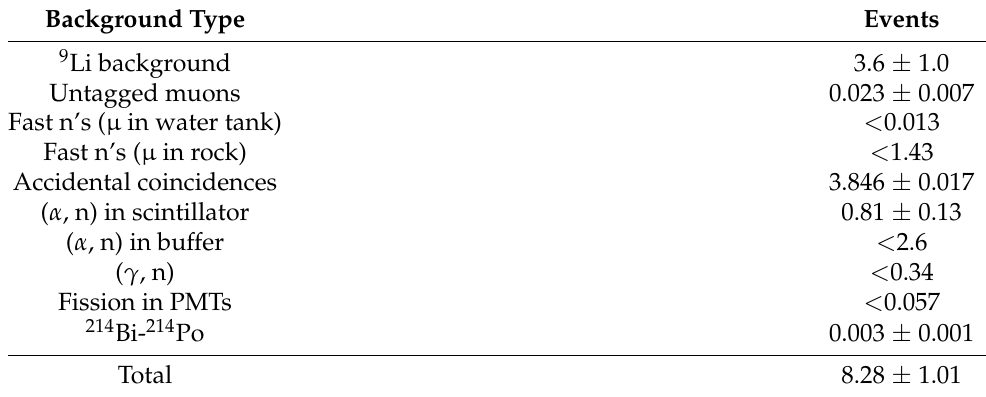
Table 8. Summary of the expected number of events from non-antineutrino backgrounds in the antineutrino candidate sample (exposure given at 95% C.L. From